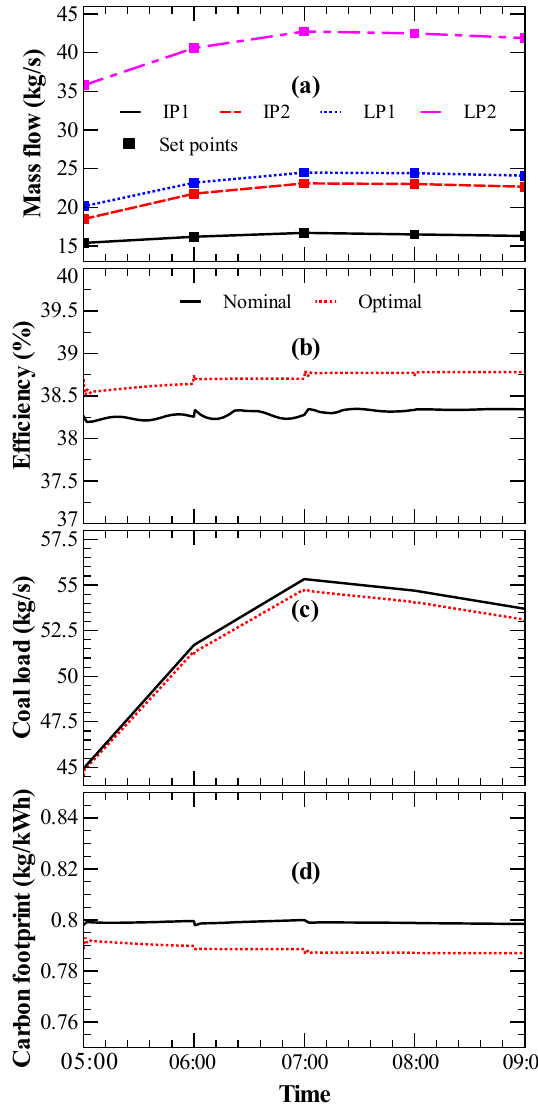
Figure 7. Dynamic optimization results of Case Study II: ( a ) dynamic measurements and set points of mass flow rates of steam extracted from turbines; ( b ) coal load; ( c ) efficiency; ( d ) carbon